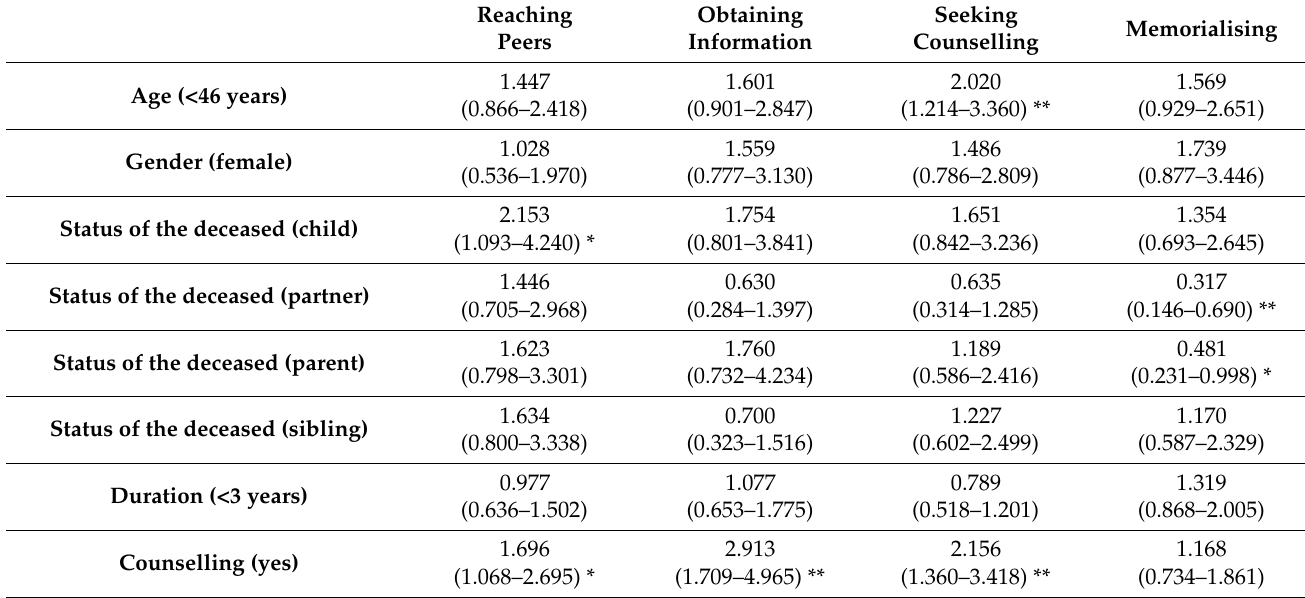
Table 5. Multivariate analysis of factors associated with the expectations regarding online resources. Reaching Obtaining Seeking Peers Information